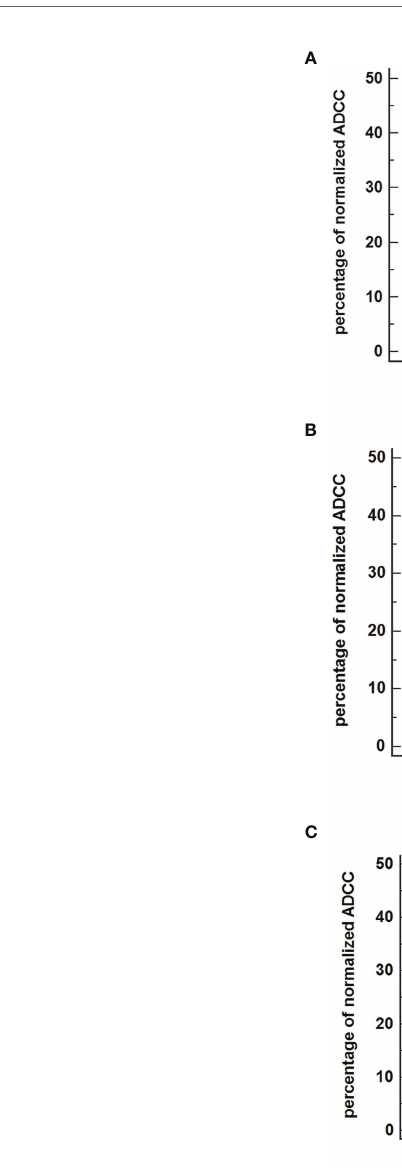
FIGURE 4 | (A) Comparison of normalized Antibody-Dependent Cell Cytotoxicity (ADCC) mediated by NK cells obtained from patients carrying the functional KIR3DL2+/HLA-A*03 or A*11 combinations and from all of the other patients carrying other KIR/HLA combinations. Each histogram represents the extent of normalized lysis of calcein-labeled MDA-MB453 cells in the presence of trastuzumab and 10,000 NK cells as effector cells. Bar height and error bars represent the mean ± standard error of the mean (SEM) for the data set. A higher ADCC ef fi cacy is mediated by effector cells of patients carrying the KIR3DL2+/ligand compared to effectors obtained from patients characterized by other KIR/HLA combinations (ANOVA test, P = 0.036). (B) Interactive action of KIR tel A or B genotype and KIR/ HLA combination on ADCC ef fi cacy showed by two ways Anova. A signi fi cant increase in cytolysis was observed by using effector cells obtained from patients carrying the tel A-Func genotype in the presence of KIR3DL2+/HLA-A*03 or A*11 compared to those obtained from patients with other KIR/ligand combinations. [% ADCC 11.94 (95%CI 5.58-18.31); % ADCC 21.10 (95%CI 2.54-39.65), t-test p=0.004]. Bar height and error bars represent the mean ± standard error of the mean (SEM) for the data set. (C) An increased effect on ADCC ef fi cacy was observed in the presence of effector cells obtained from patients carrying both the Fc g R3A V- allele (Fc-V) and the KIR3DL2+/HLA-A03 or A*11 compared to those carrying the Fc g R3A F-allele (Fc-F) and other KIR/HLA combinations [% ADCC =3.47 vs 19.21, p<0.05]. A signi fi cant difference was also observed between other KIR/Ligand combinations according to the Fc g R3A allele [% ADCC others+Fc-F = 3.47 others +Fc-V= 11.06, Kruskal-Wallis test P